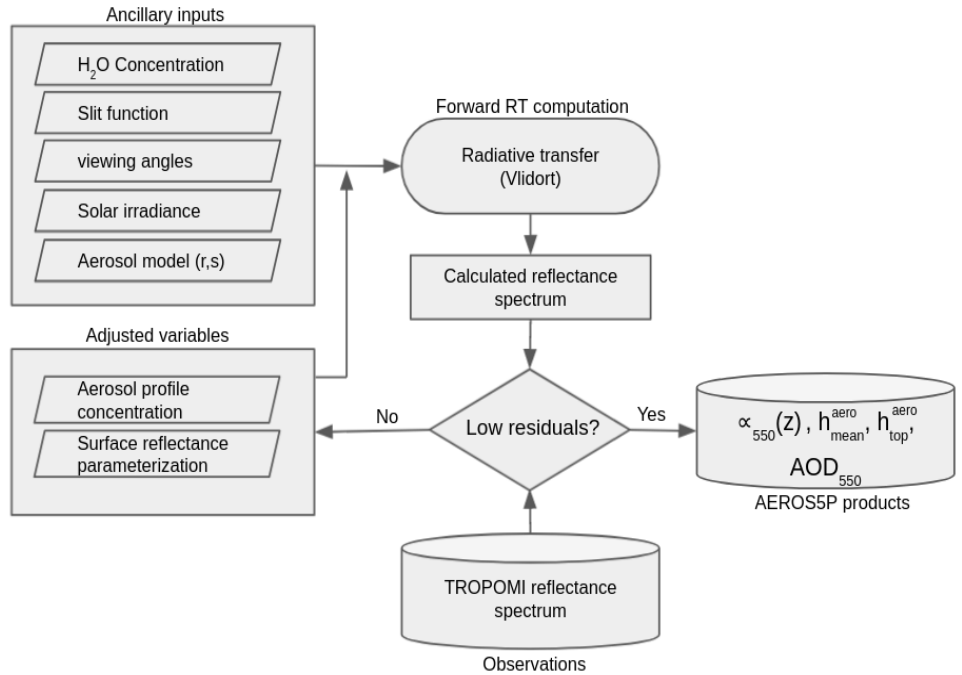
Figure 1. Scheme of the AEROS5P algorithm for retrieving the 3D distribution of fine BB aerosols. r: aerosol size distribution modal radius; s: aerosol size distribution standard deviation; h mean : aerosol layer mean height; α 550 : aerosol extinction profile at 550 nm; h top : aerosol layer top height; AOD 550 : aerosol optical depth at 550 nm.